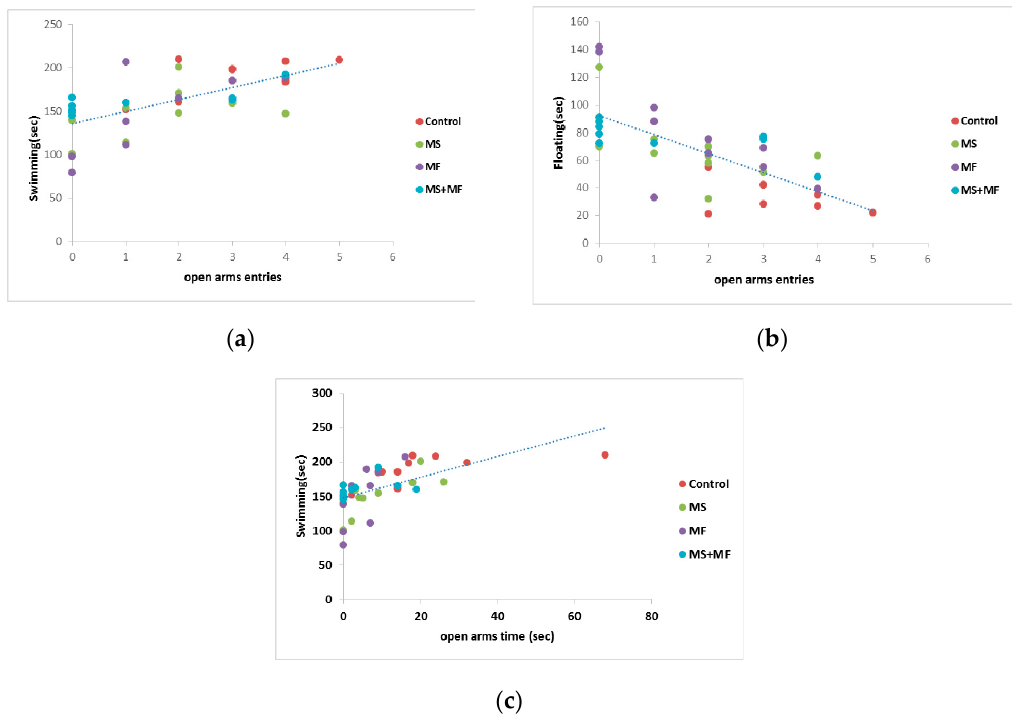
Figure 8. Statistical correlations between behavioral parameters: ( a ) swimming vs. frequency of open arms entries, ( b ) floating duration vs. frequency of open arms entries, ( c ) swimming vs. open arms time ( n = 40, OAE = open arms entries, OAT = open arms time).